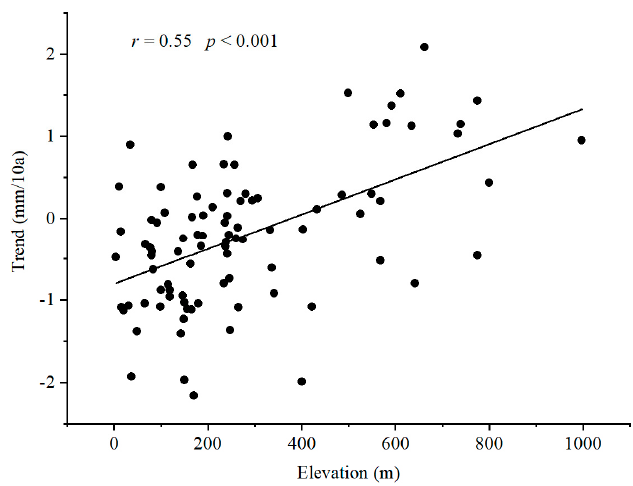
Figure 4. Spatial patterns of trends in ET 0 ( a ), WS ( b ), RH ( c ), SD ( d ), and T ( e ) over Northeast China during the period of 1961–2017. The trends in stations with red squares were significant ( p < 0.05).